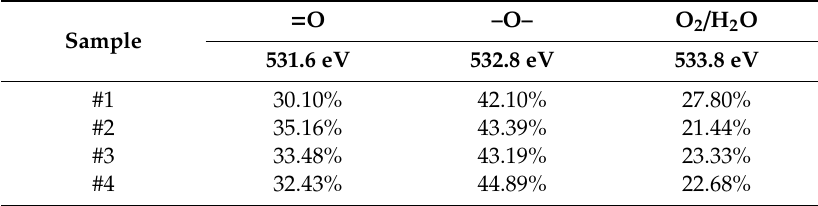
Table 5. Bonding state content of the O element of each carbonaceous deposit layer.